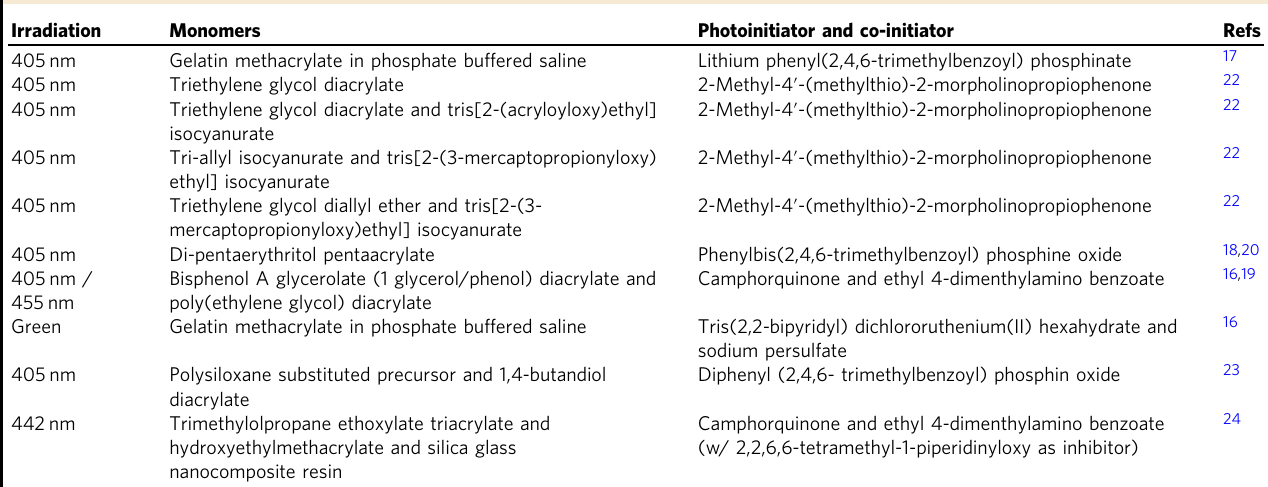
Table 1 Photoresins investigated in tomographic volumetric 3D